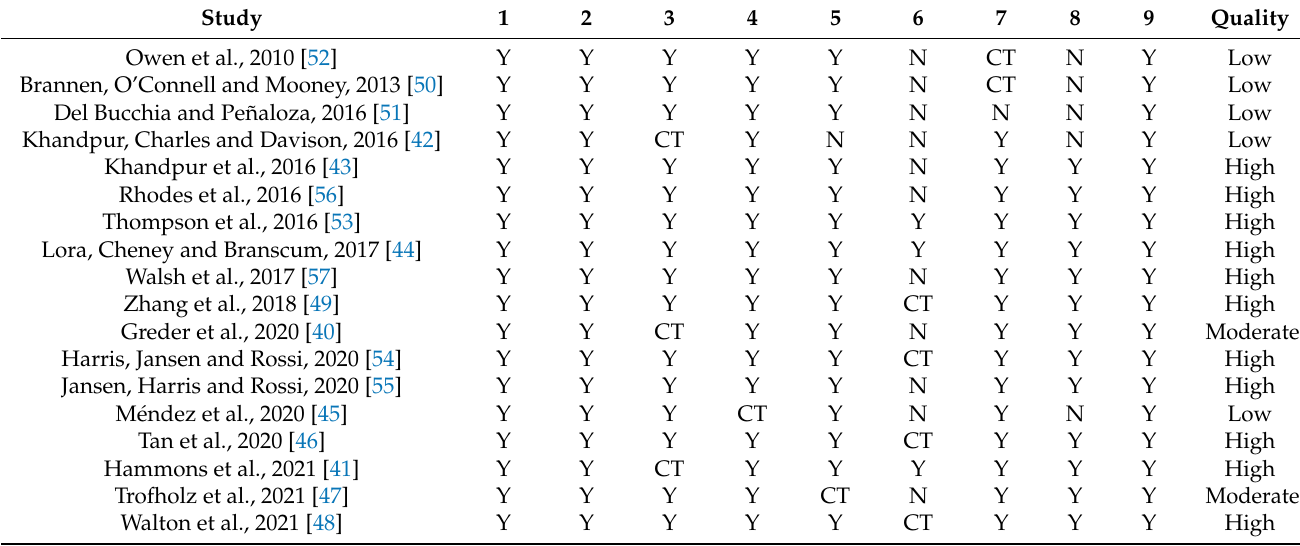
Table 3. Results of quality